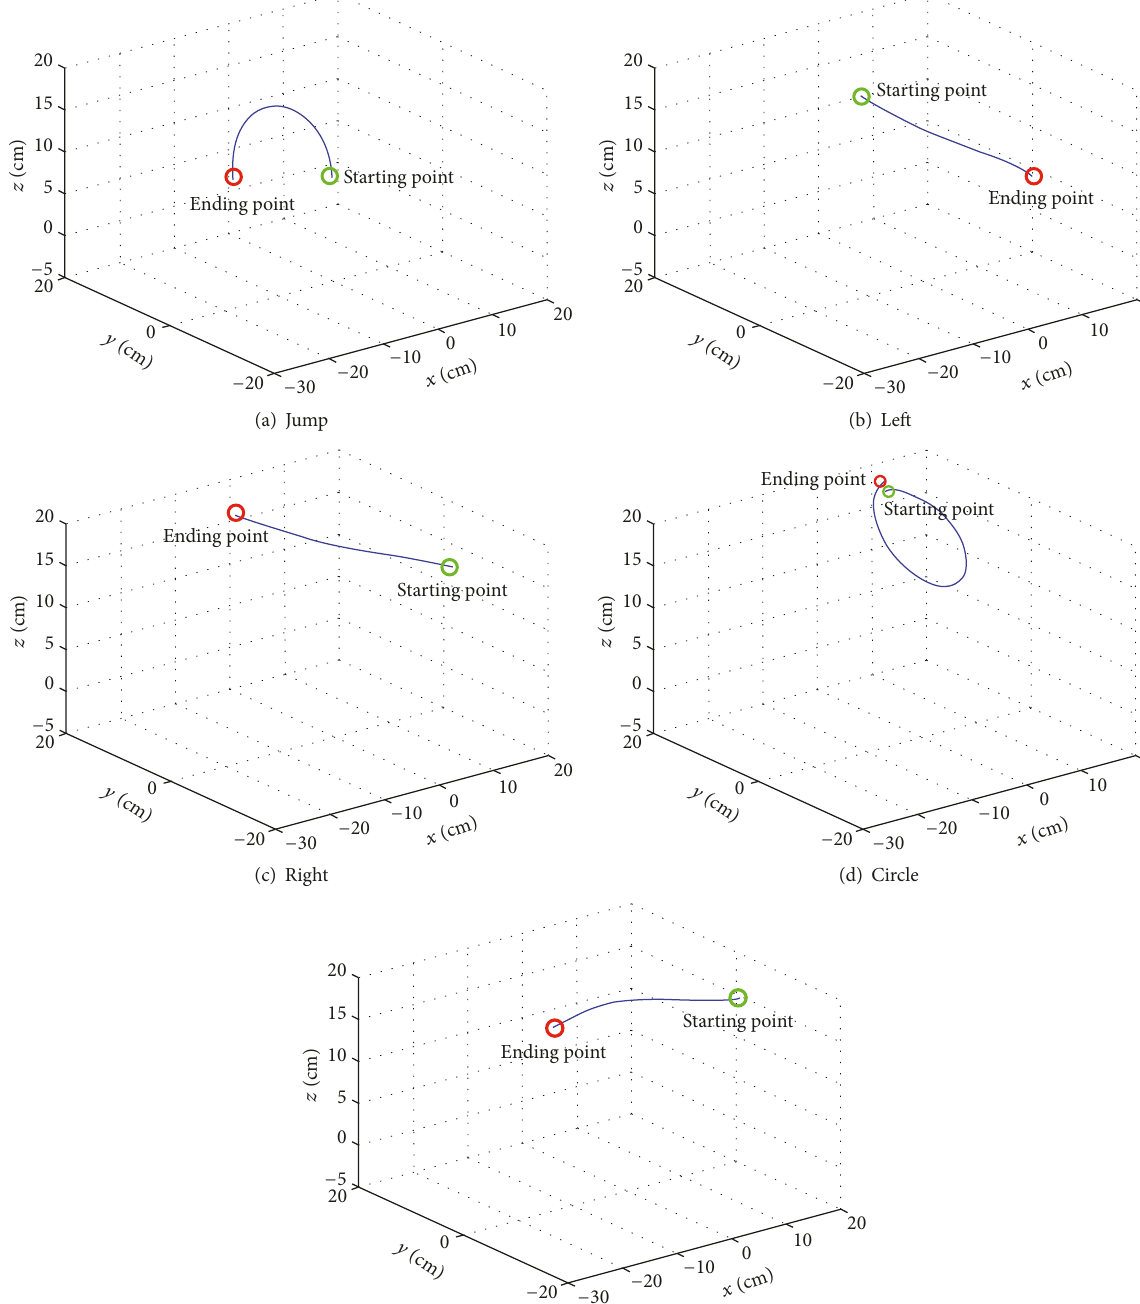
Figure 17: Trajectory samples of five classes. The starting point is marked in green, and the ending point is in red.